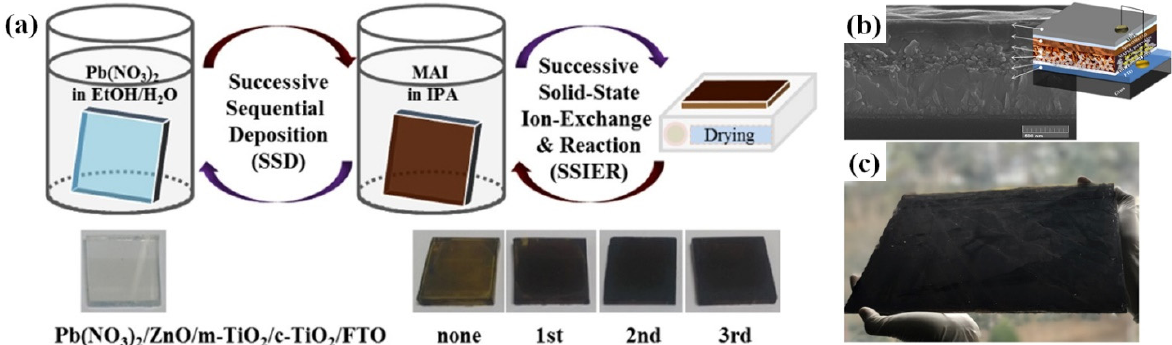
Figure 13. Schematic processes for film coating: ( a ) dip coating; ( b ) blade coating, and ( c ) slot-die coating. Reprinted from